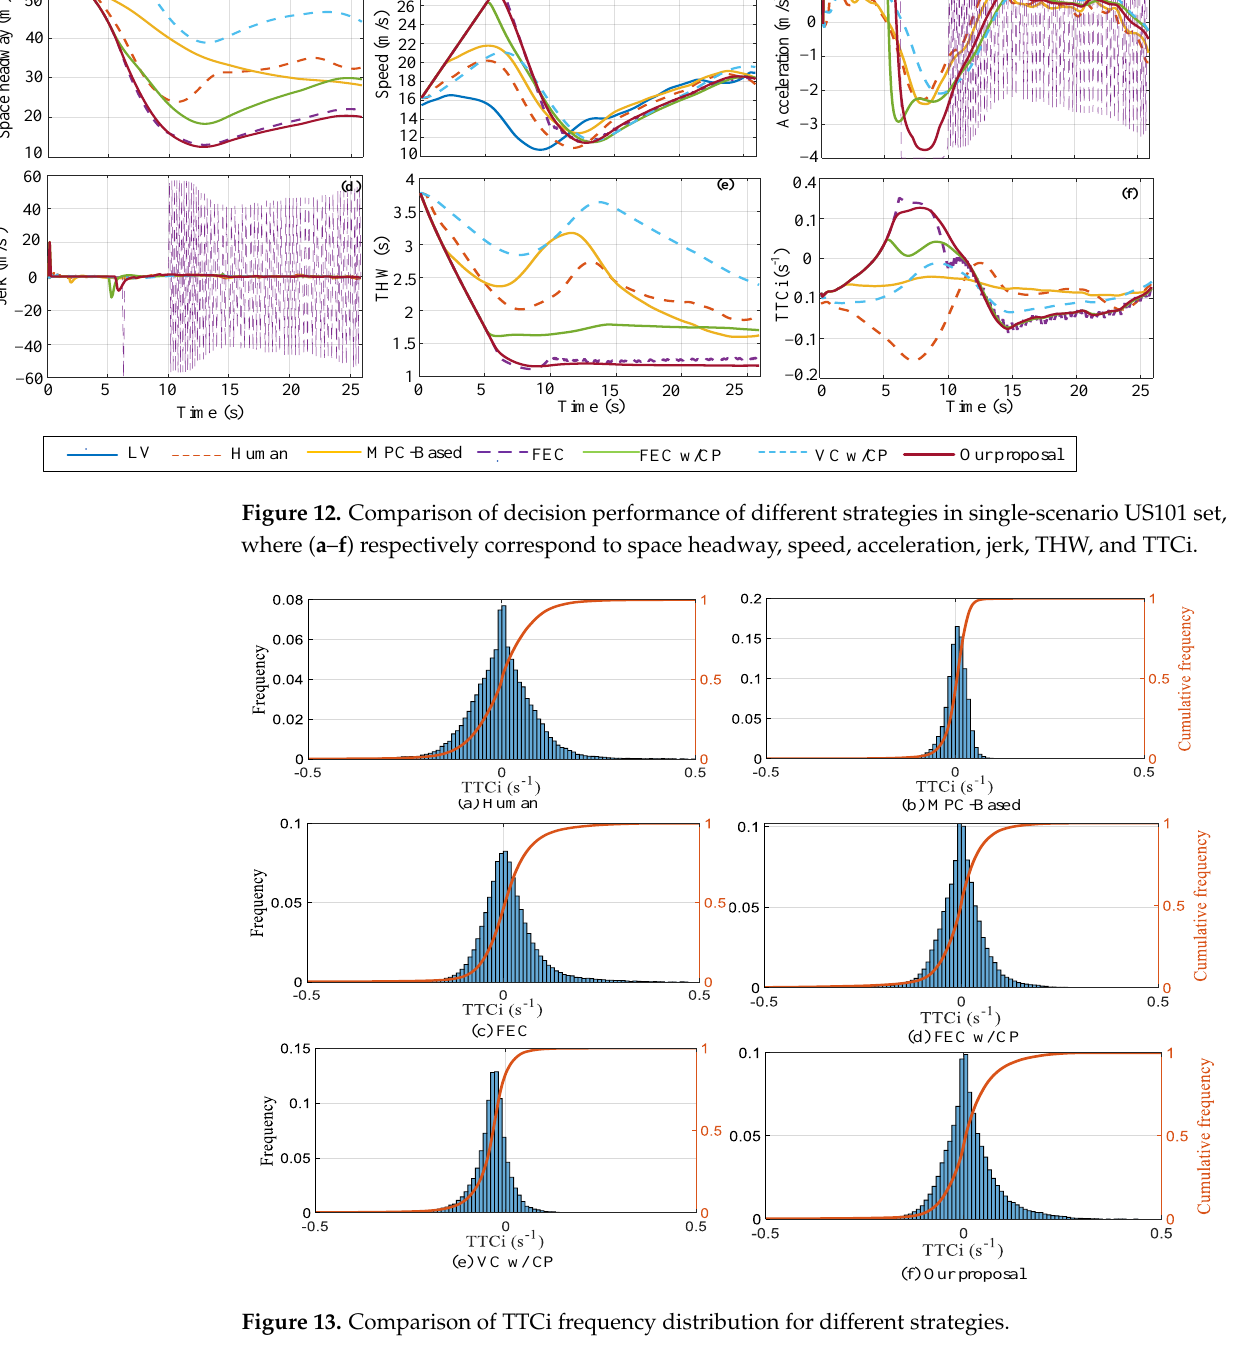
Figure 13. Comparison of TTCi frequency distribution for different strategies.